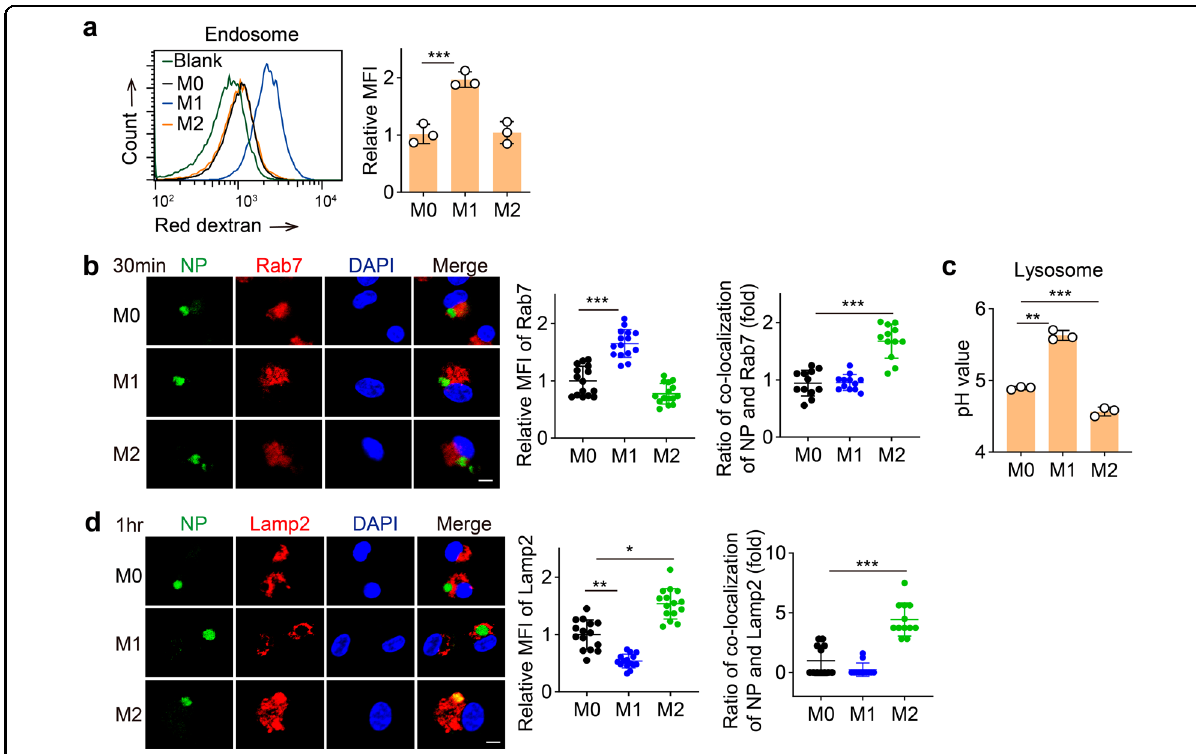
Fig. 4 The pH value in endosome or lysosome affects the viral replication in AMs. a M0, M1, and M2 AMs were stained with pHrodo ™ Red dextran and the fl uorescence intensity was determined by fl ow cytometry. b, d AMs were infected with SARS-CoV-2 for 30 min ( b ) or 1 h ( d ), and then stained with anti-NP, anti-Rab7, and anti-lamp2 antibodies. Scale bar, 5 μ m. c M0, M1, and M2 AMs were stained with LysoSensor ™ Yellow/Blue DND-160 and the pH value was detected by a microplate reader. The data represent the mean ± SD of 3 independent experiments. * P < 0.05, ** P < 0.01, *** P < 0.001, by one-way ANOVA ( a – d